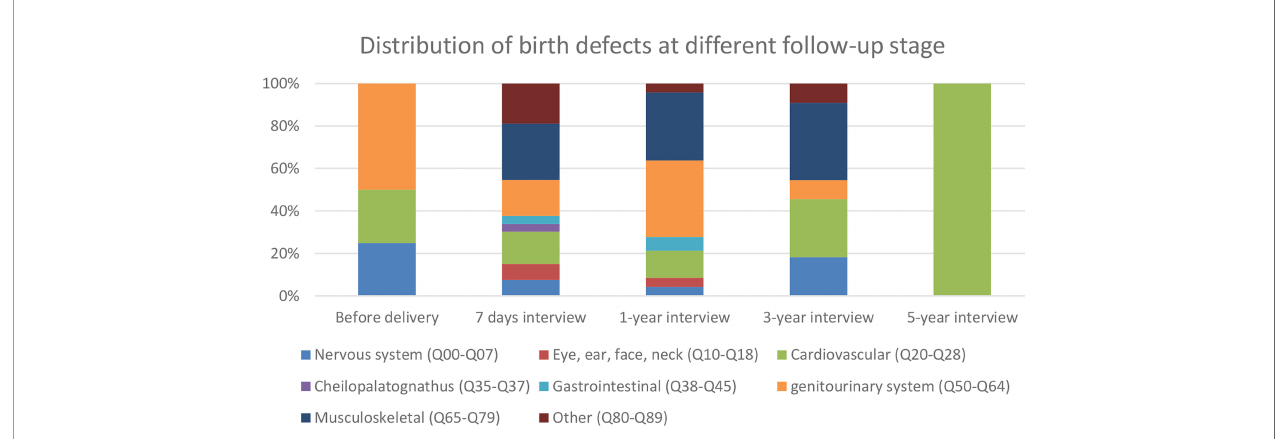
FIGURE 3 | Distribution of birth defects at different follow-up stages.